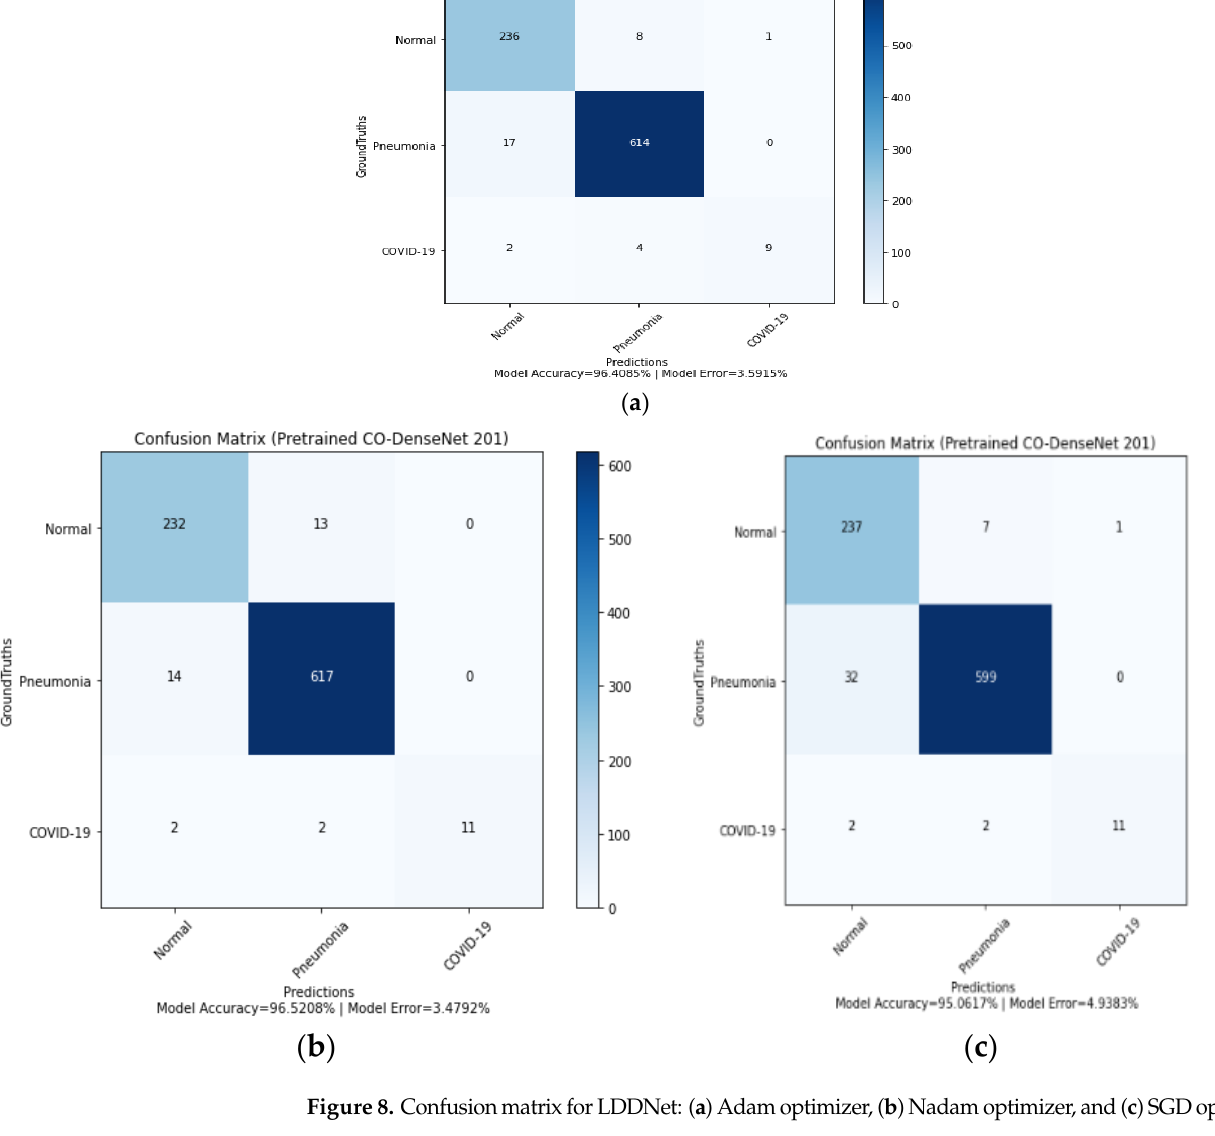
20 of 27 Table 10. Comparison of the different DL models for the SGD optimizer. Model